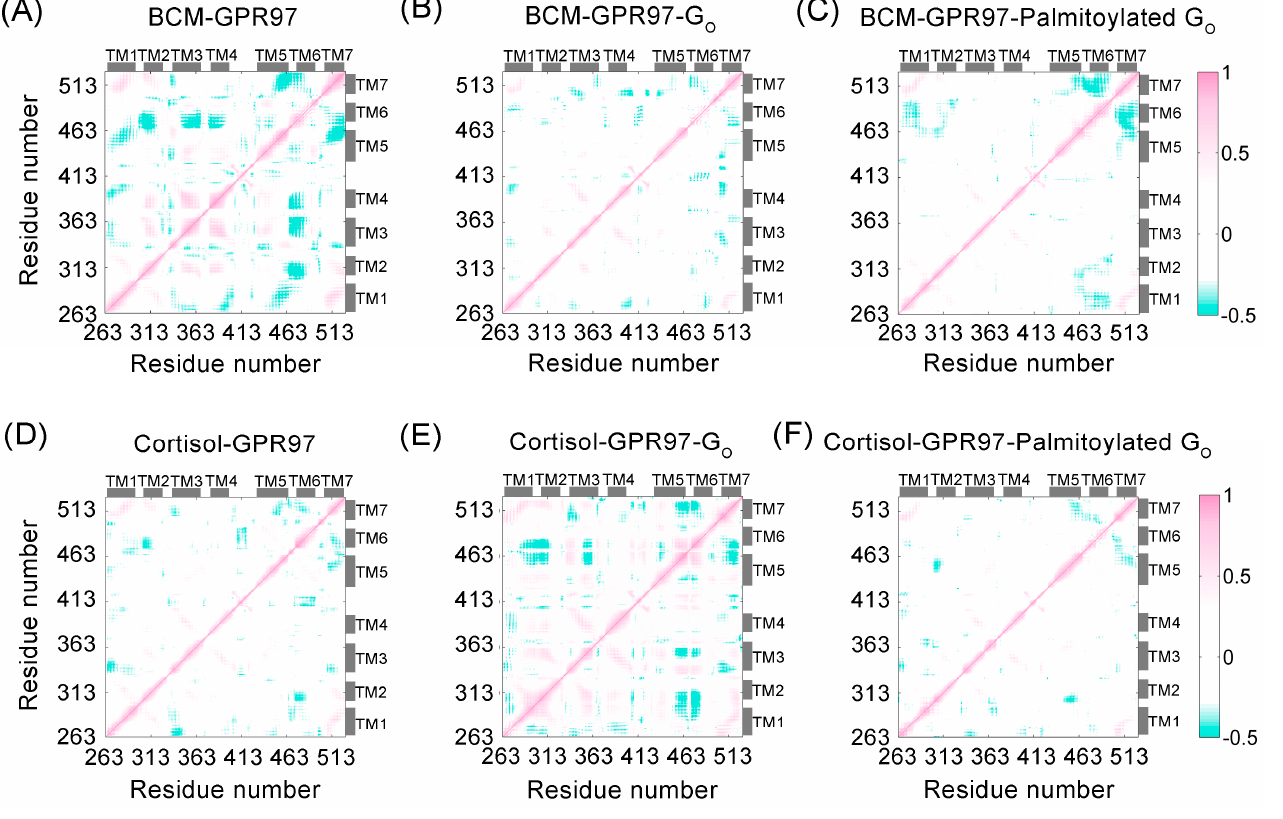
Figure 3. DCCM plots of BCM–GPR97 ( A ), BCM–GPR97–G o ( B ), BCM–GPR97–palmitoylated G o ( C ), cortisol–GPR97 ( D ), cortisol–GPR97–G o ( E ), and cortisol–GPR97–palmitoylated G o ( F ) systems. Positive areas (pink) indicate correlated motion, whereas the negative areas (green) denote anti-correlated motion. The correlation motions with absolute values less than 0.3 are ignored and shown in white.